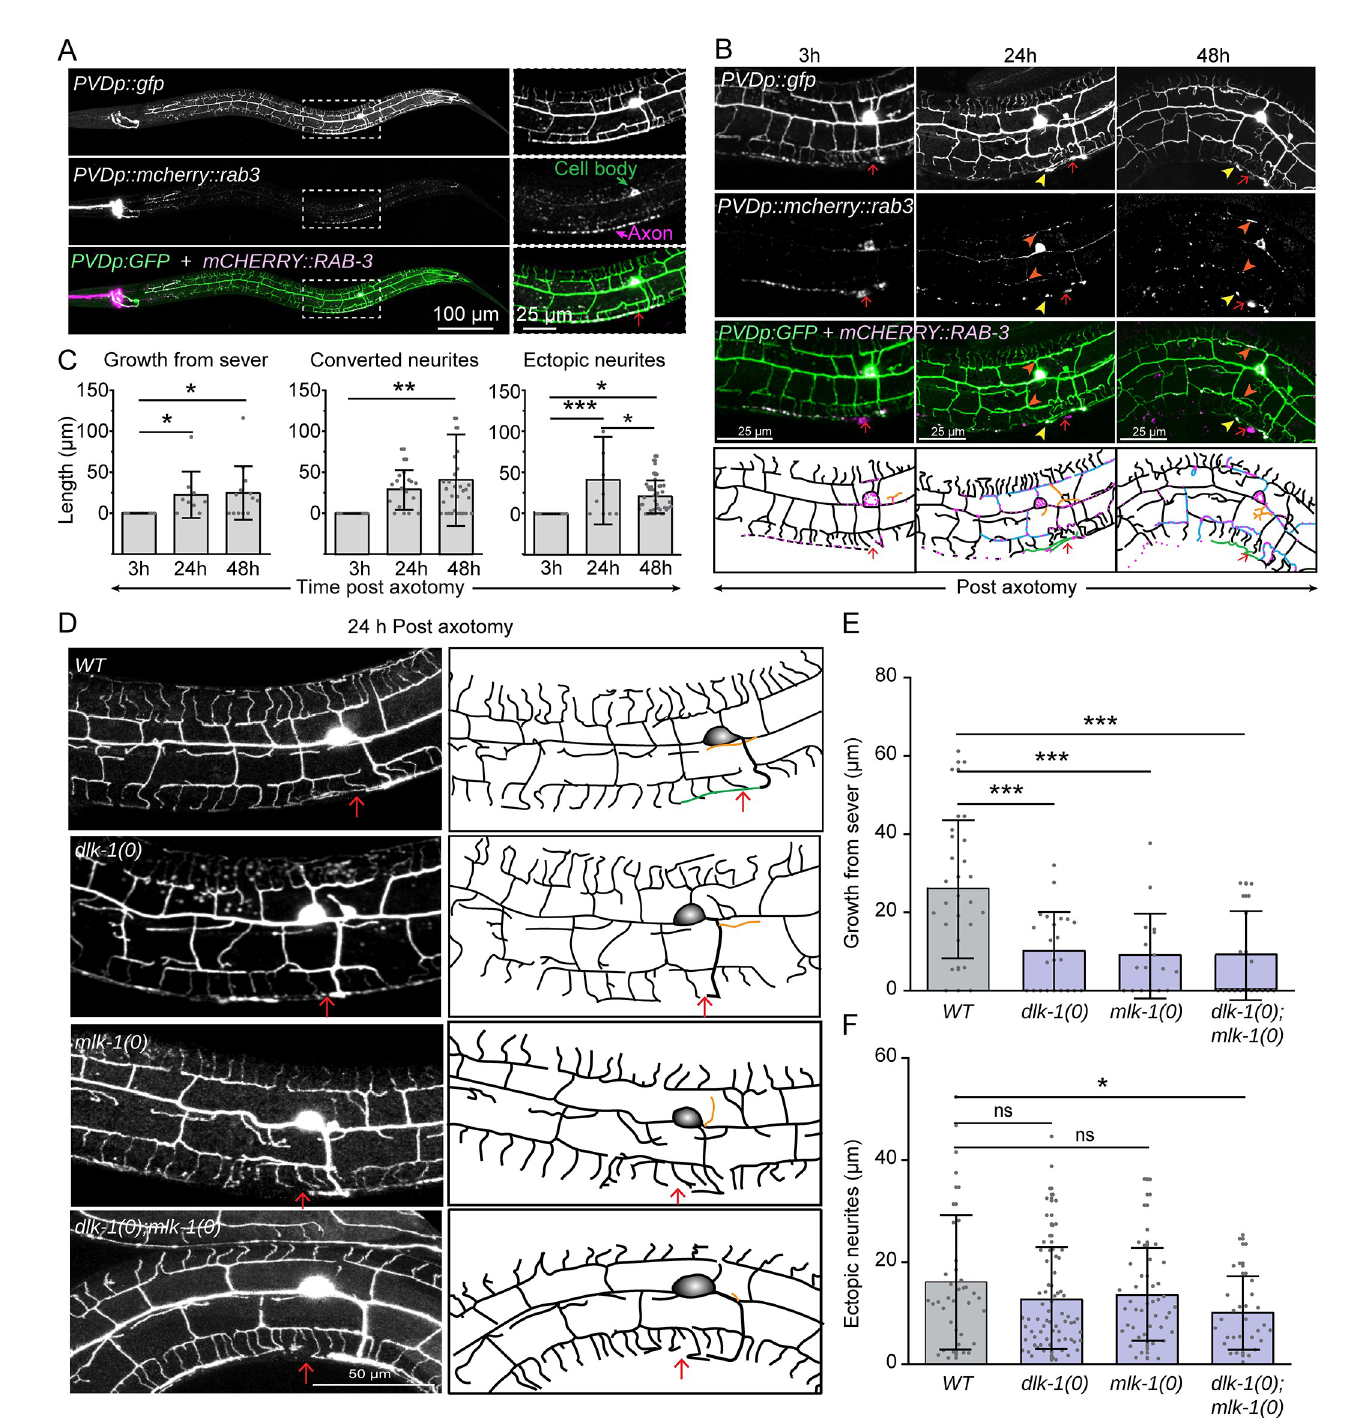
Fig 3. Axon regeneration in PVD neuron requires the DLK-1/MLK-1 pathway. (A) Representative images of PVD neuron labeled with wdIs52 ( pF49H12 . 4 :: GFP ,green) and kyIs445 ( pdes-2 :: mCherry :: RAB-3 ,magenta) with the region of interest (white dashed rectangle) magnified in the respective insets. mCherry::RAB-3 punctae localized to the cell body and axon (marked in the inset). The site of axotomy using femtosecond laser is labelled using a red arrow. (B) Representative images and schematics of PVD neurons labeled with GFP and mCherry::RAB-3 ( kyIs445;wdIs52 ) in green, magenta and merge channels at 3, 24, and 48h post-axotomy (red arrow) at L4 stage. Following axotomy, the axon shows regenerative growth from the severed end (green traces) with mCherry::RAB-3 on the tip (yellow arrowhead), converted neurites (blue traces) which are adjacent dendrites showing mCherry::RAB-3 localization (orange arrowheads), and ectopic neurites from the cell body and proximal axon (orange traces